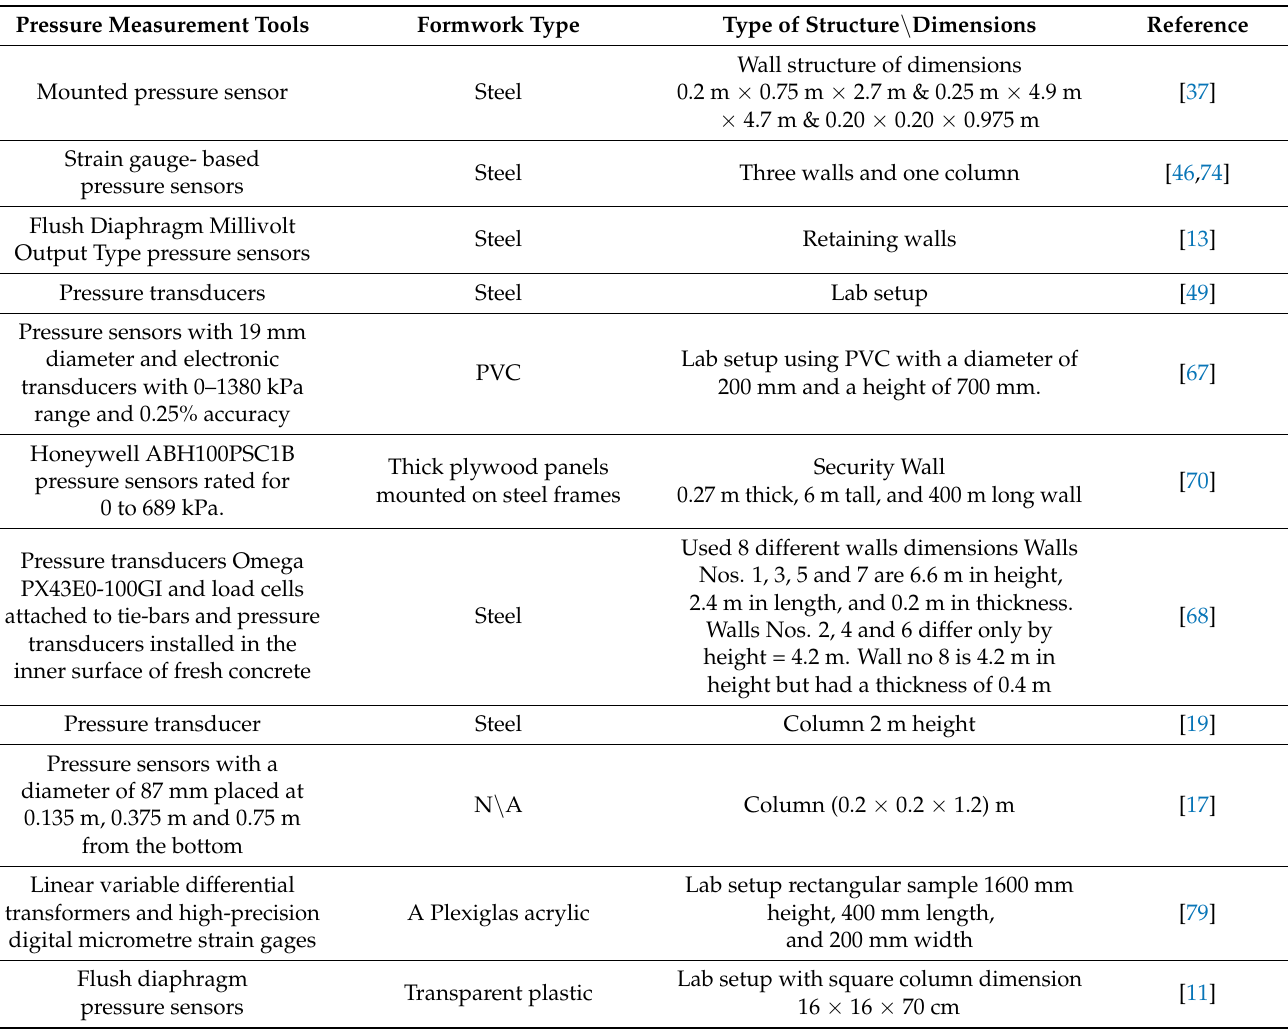
Table 5. Formwork pressure measurement